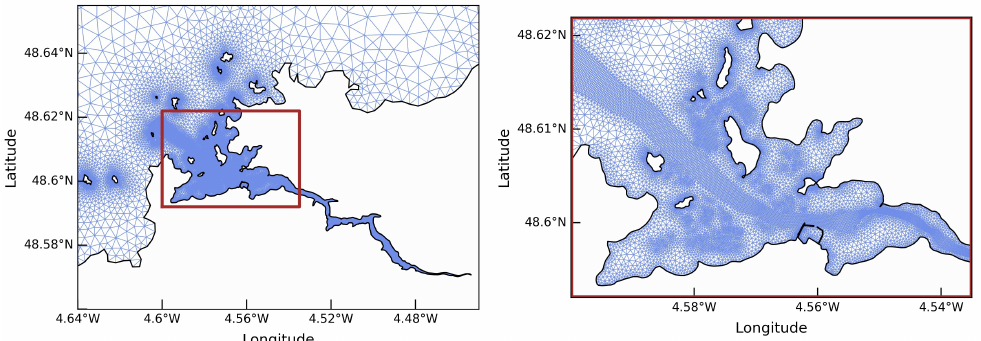
Figure 5. Extents of the unstructured computational grid in the Aber Wrac’h